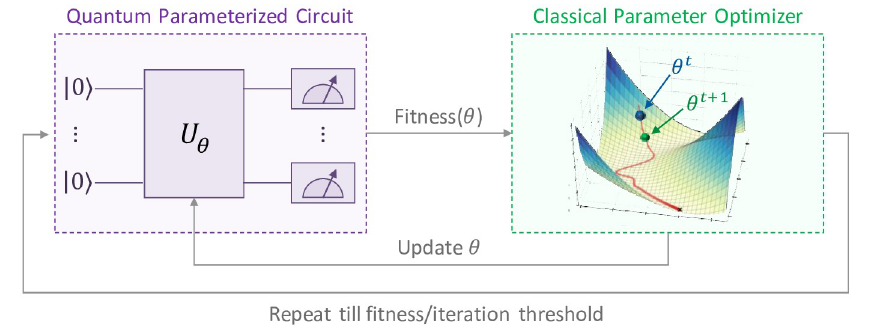
Fig 4. Variational hybrid quantum-classical approach for